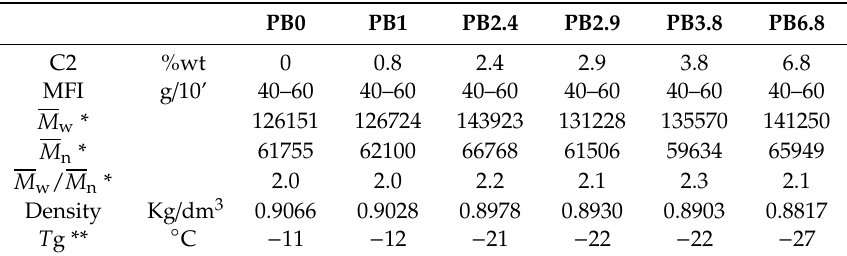
Table 2. Samples